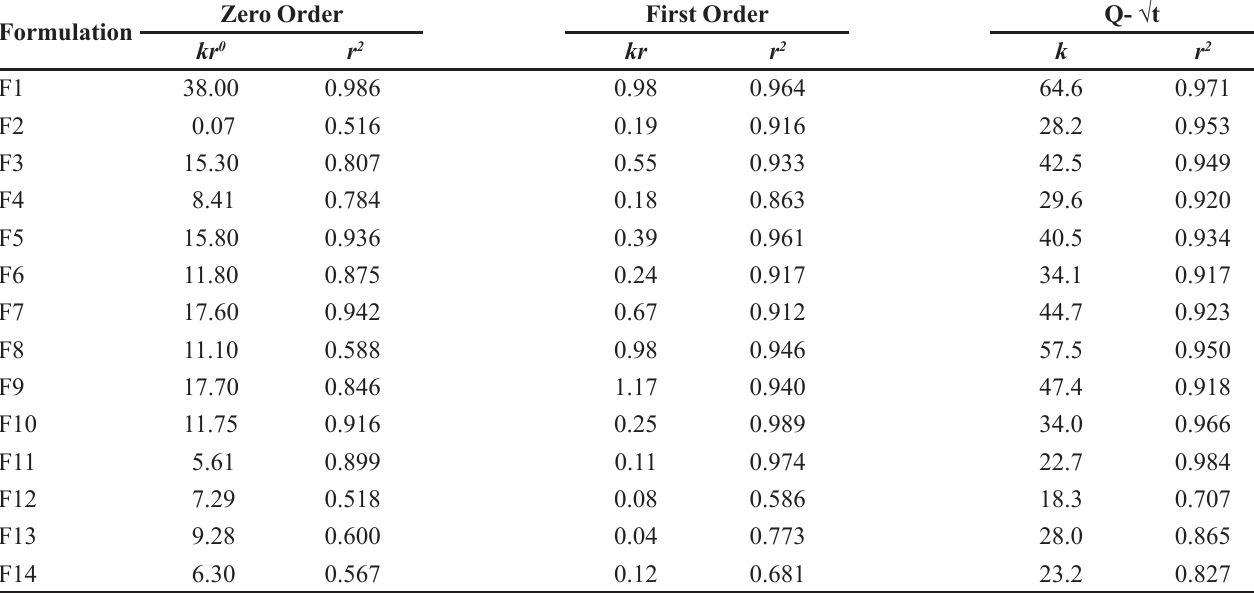
TABLE IV - The kinetic assesment of release data